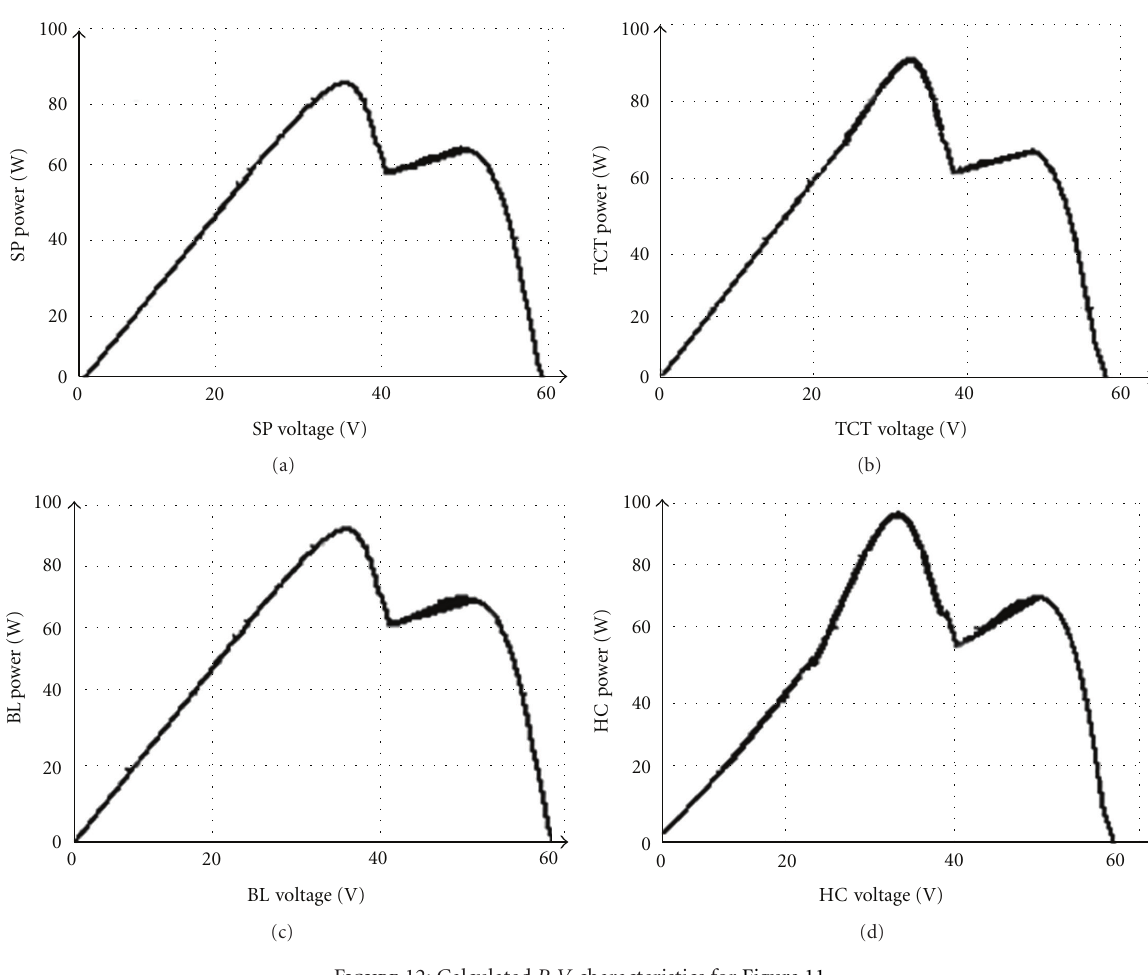
Figure 12: Calculated P-V characteristics for Figure 11.